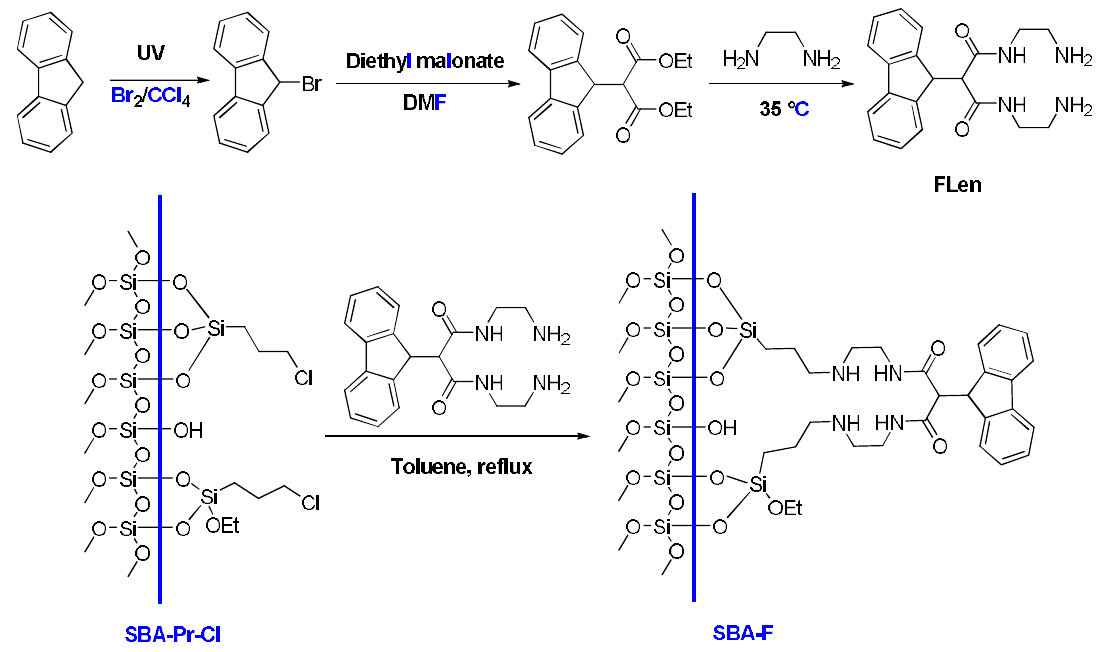
Fig. 14. Modification of SBA-15 with the synthesized bis(2-aminoethyl)-2-(9-fluorenyl)malonamide.